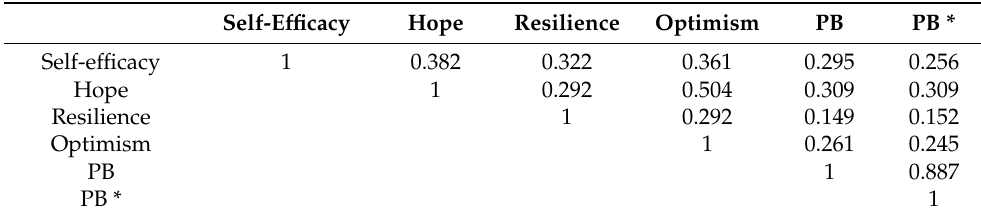
Table 5. Nomological